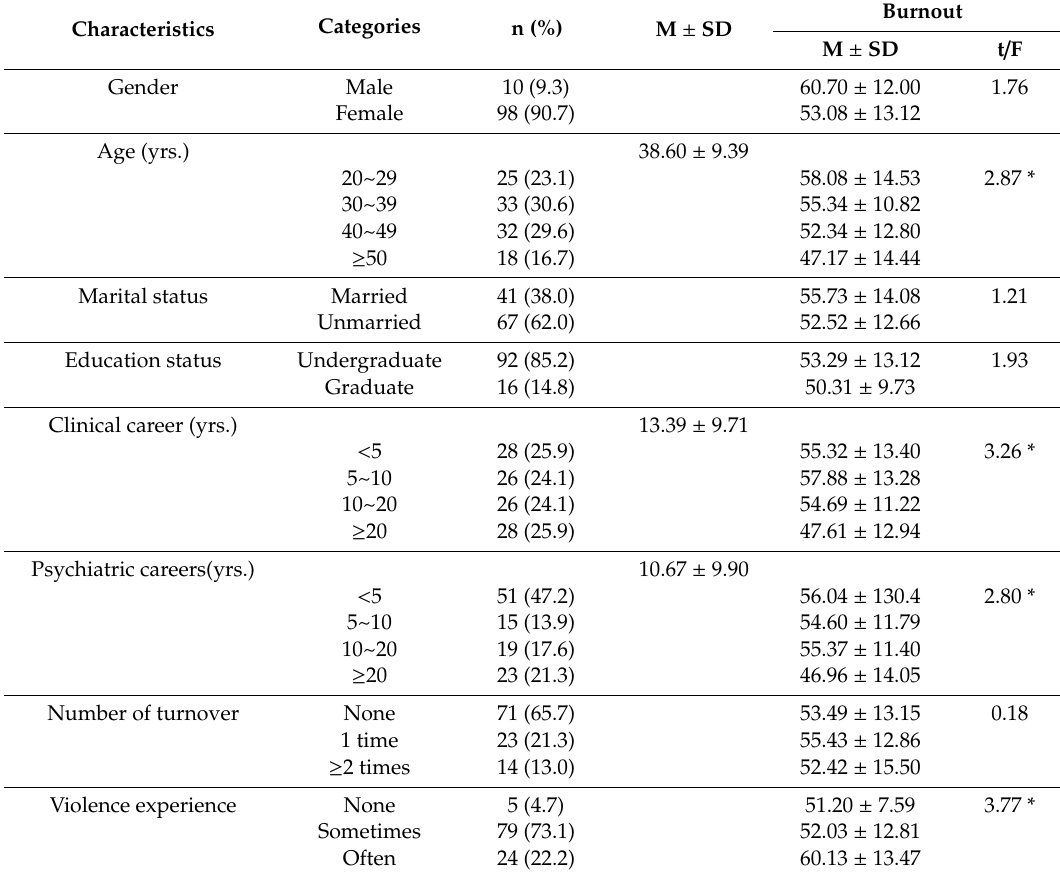
Table 1. Participant characteristics, di ff erences of burnout by characteristics.